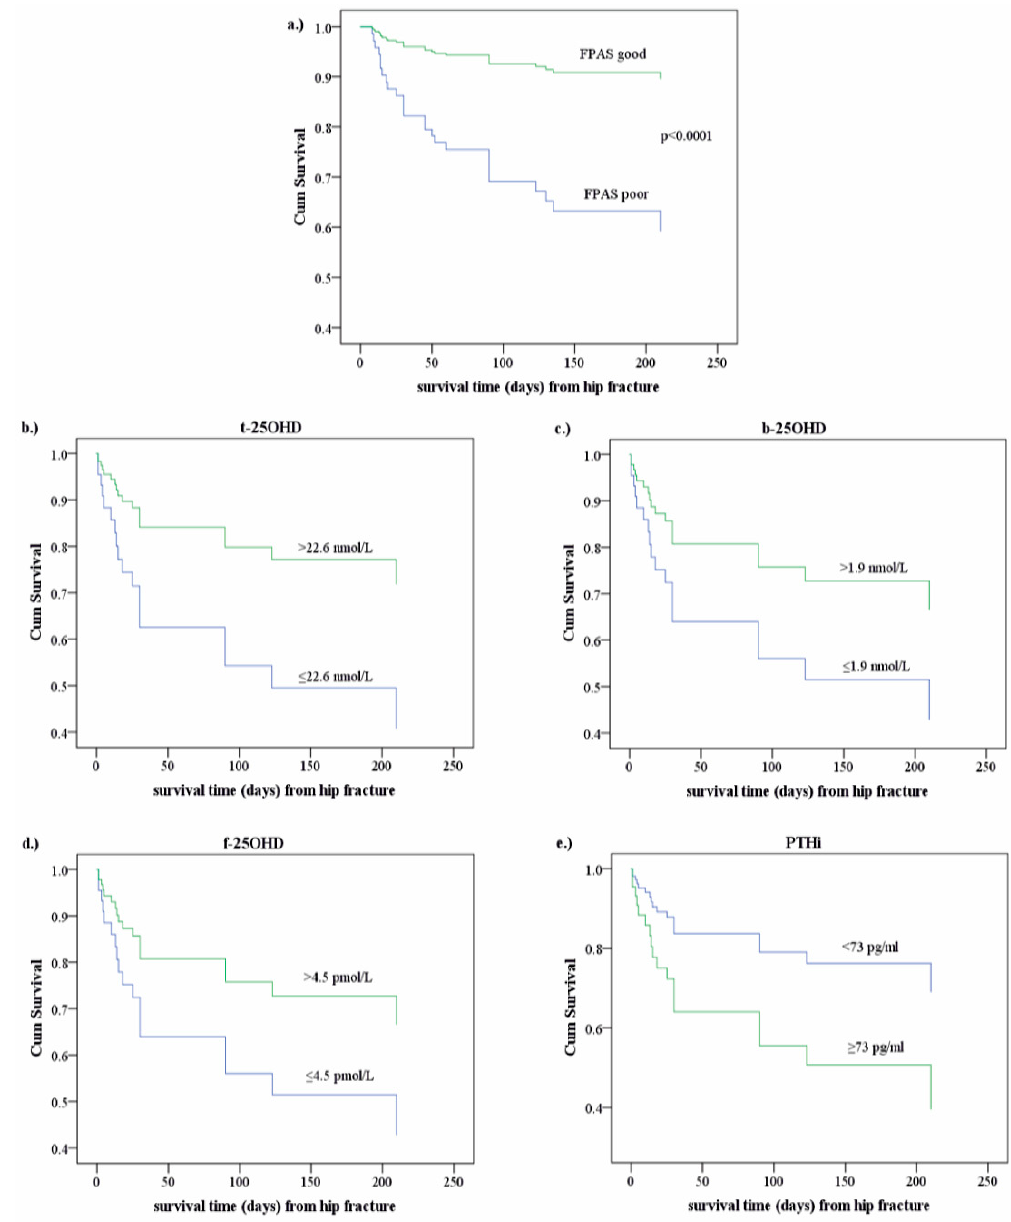
Figure 2. Effects on survival. ( a ) The effect of postoperative functional performance: Cum: cumulative, FPAS: functional performance after surgery. The chance to survive is more than six times higher (OR = 6.5 CI:3.2–13.3 ; p < 0.0001) in patients with good FPAS than for patients with poor (FPAS), before discharged. Cox-regression was performed on adjusting age and kidney/malignant diseases. ( b – e ) Influence of favorable 25OHD fractions and PTHi levels on survival in patients with poor postoperative performance: ( b ) t-: total, ( c ) b-: bioavailable, ( d ) f-: free 25OHD vitamin; ( e ) PTHi: intact parathyroid hormone, Cum: cumulative; Cox regressions controlled by age and kidney and malignant diseases, concerning only 43 patients with poor functional performance after surgery. PTHi: p = 0.204; t-25OHD: p = 0.084; b-25OHD and f-25OHD: p = 0.178.